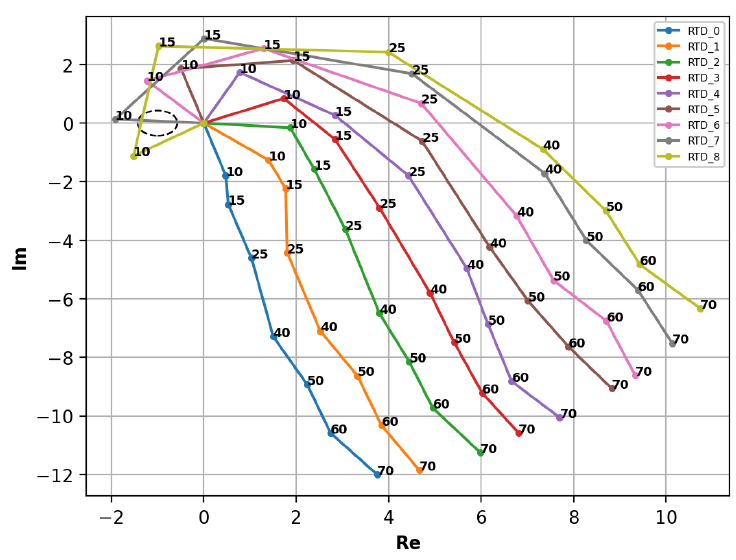
Figure 10. Multiple Bode plots depicting the impact of injected latency to FCR frequency response (phase in radians).